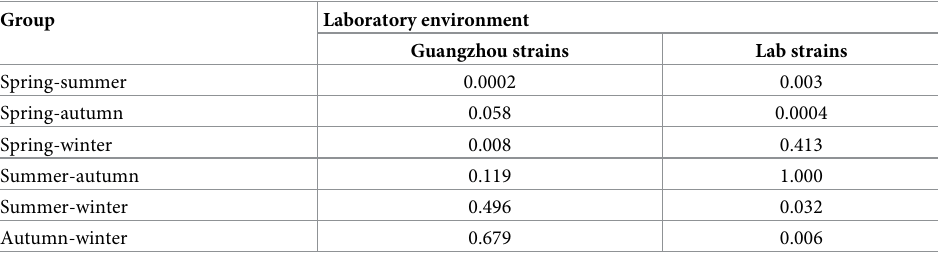
Table 1. P value for pairwise comparison of four seasonal pupation rates in different experimental groups.